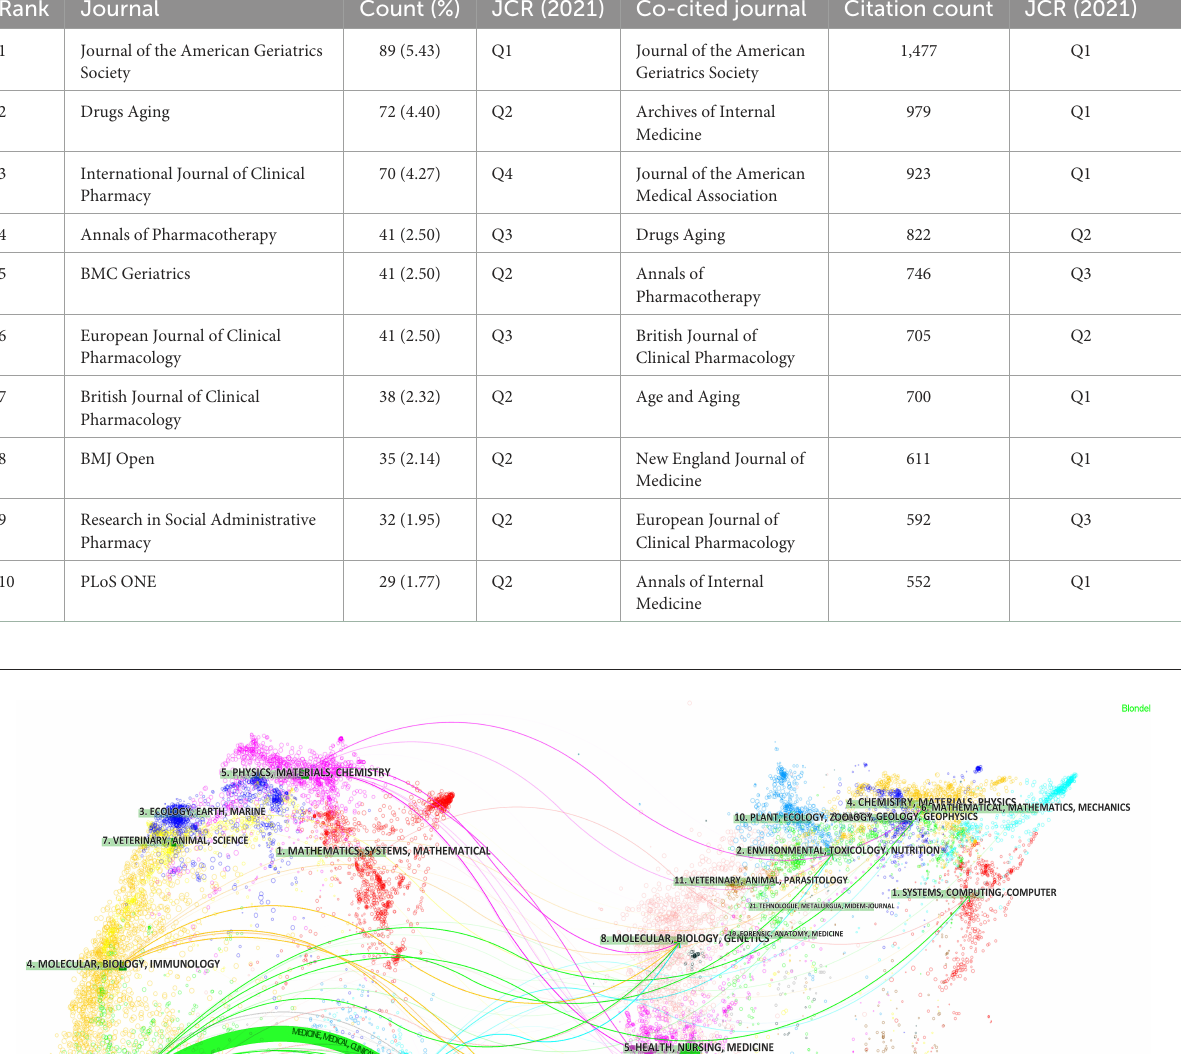
TABLE 4 Top 10 journals in terms of publications and co-cited journals in terms of citations from 2000 to 2021.